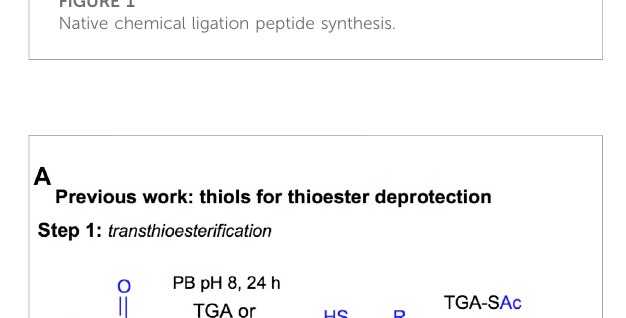
FIGURE 1 Native chemical ligation peptide synthesis.